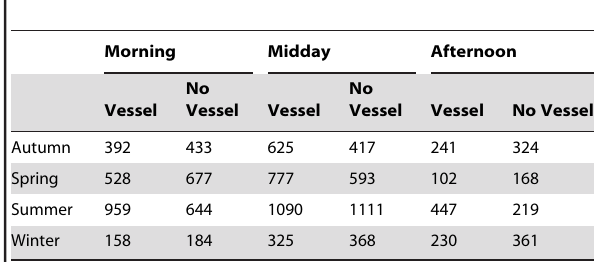
Table 2. Count of observed behavioural state transitions by season, time of day, and vessel presence.